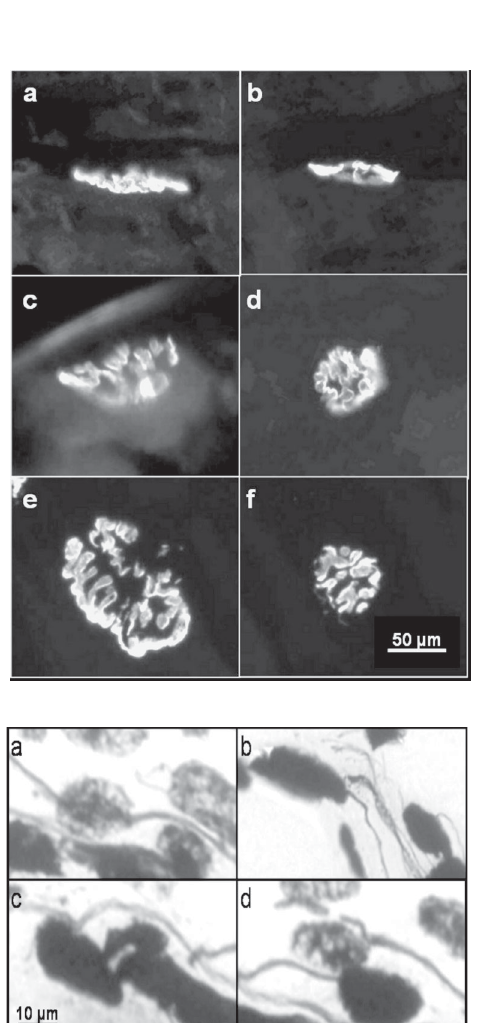
Figure 4. Nicotinic acetylcho- line receptor clusters in ec- topic muscle and in cultured muscle fibers. Tissue sections from 3-day ectopic skeletal muscle fibers (a) or from cul- tured rat skeletal muscle fi- bers (b) were labeled with tet- ramethylrhodamine-labeled α -